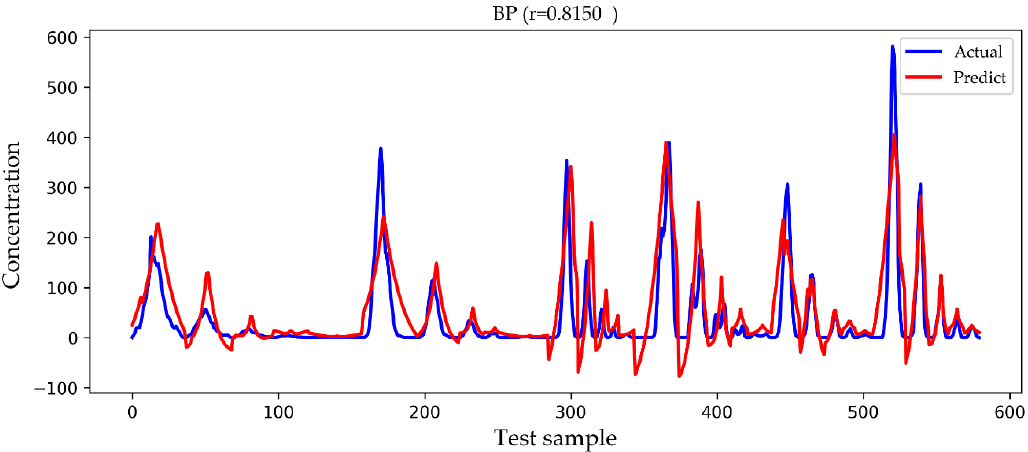
Figure 11. A comparison of the actual and predicted values of the BP model. An independent experiment was taken that was close to the average result but not included in the statistics.